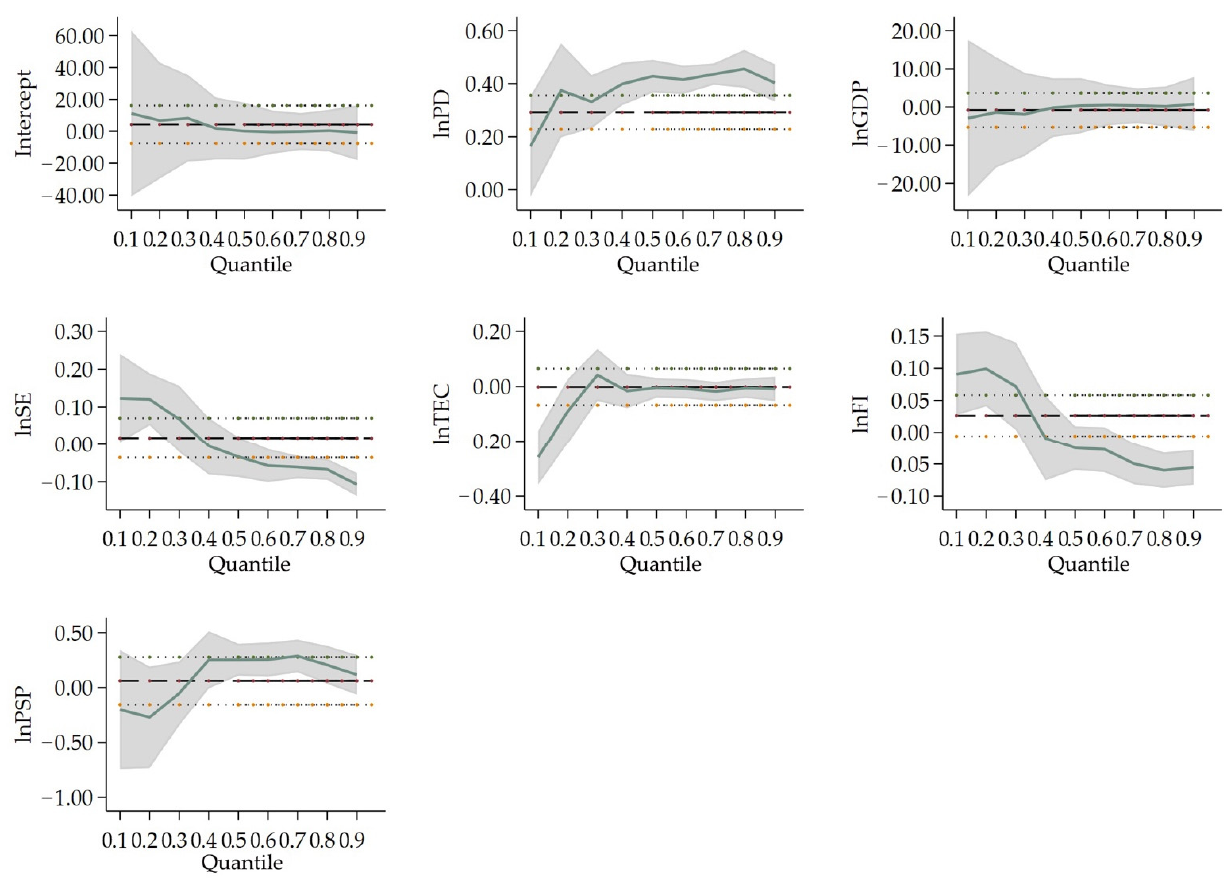
Figure 3. Change in variables’ coefficients in Type II cities’ quantile regression. Notes: the labels for all lines, the horizontal and vertical axis are the same as above.